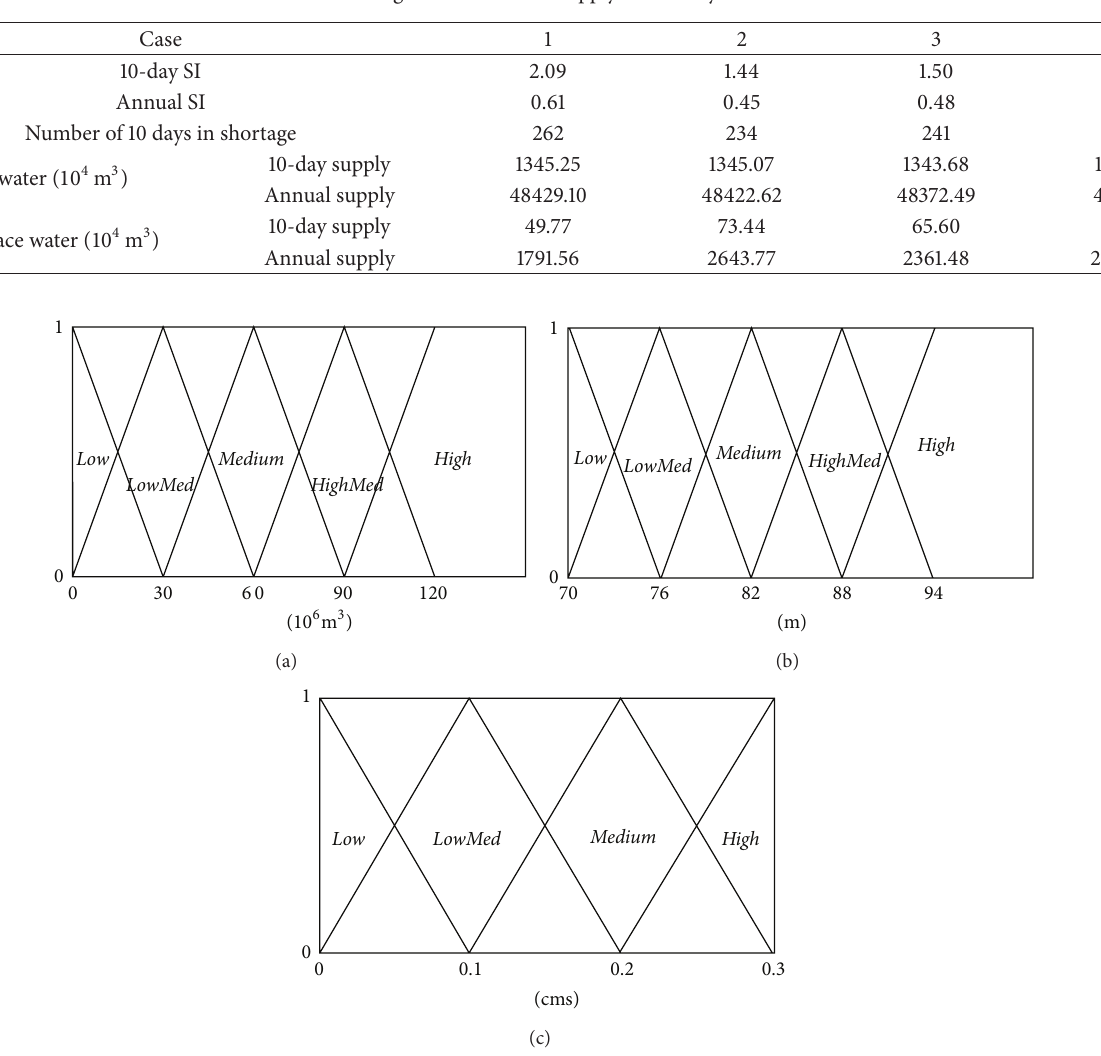
Figure 3: Fuzzy membership function for (a) input 1: surface water state, (b) input 2: subsurface water state, and (c) output: pumping rate.